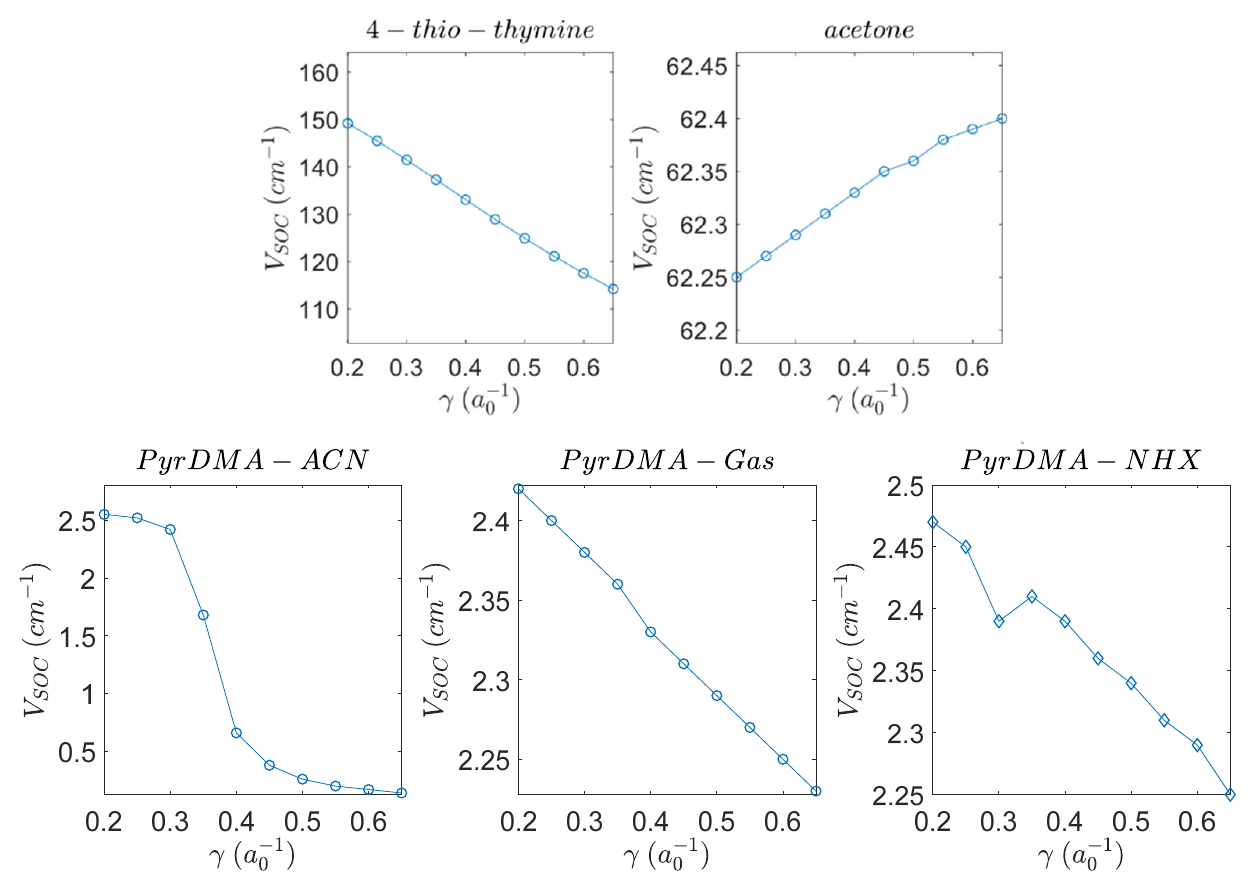
Figure 3. The dependence of V SOC values for 4-thio-thymine, acetone and PyrDMA as a function of the range separation parameter γ (units of inverse Bohr radius = 52.9117 pm) in the gas-phase. Two solvents are also shown for PyrDMA. The geometries are calculated with a TZP basis and PBE XC, while the SOC values are calculated using a TZP basis and the CAMY-B3LYP XC functional. The behavior is similar to the results on acetone and 4-thio-thymine from Gao